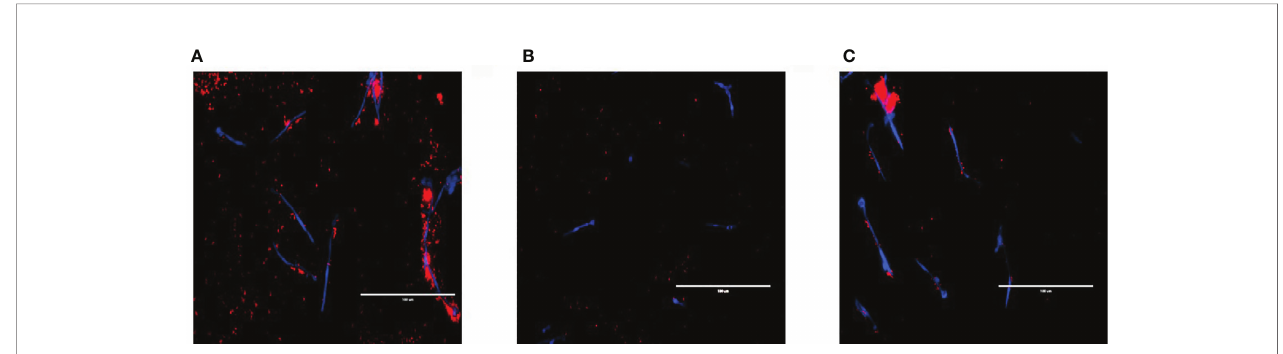
FIGURE 3 | Visualising cell-cell interactions between Candida mutants and S. aureus. C albicans bio fi lms of (A) wild type SC5314 and (B) ALS3 and (C) ECE1 deletion mutants were grown for 2 h before adding 5x10 7 cells/mL of S. aureus (which had been pre-stained with hexidium iodide for 1 h prior) for a further hour. Calco fl uor white was added to the bacterial inoculum to stain the fungal bio fi lm before washing the bio fi lm to remove any non-adherent cells before imaging. Scale bars represent 100 m m.